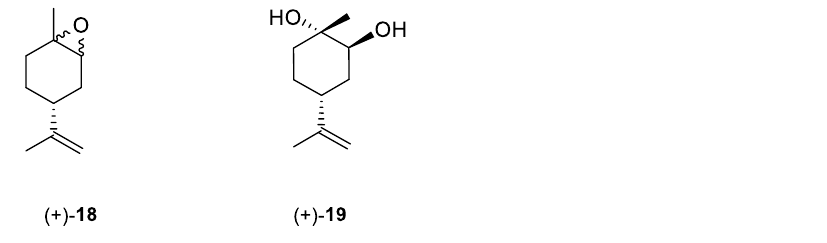
Figure 8. Structures of limonene derivatives: (+)-limonene 1,2-epoxide 18 and (+)-limonene-1,2-diol 19